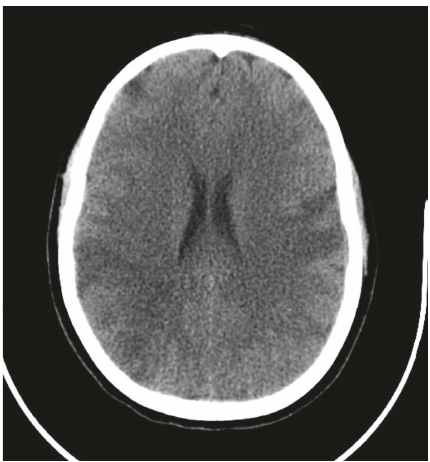
Figure 1: Image from the patient’s CT brain without contrast demonstrating multiple acute infarcts, including right middle cere- bral artery (MCA)